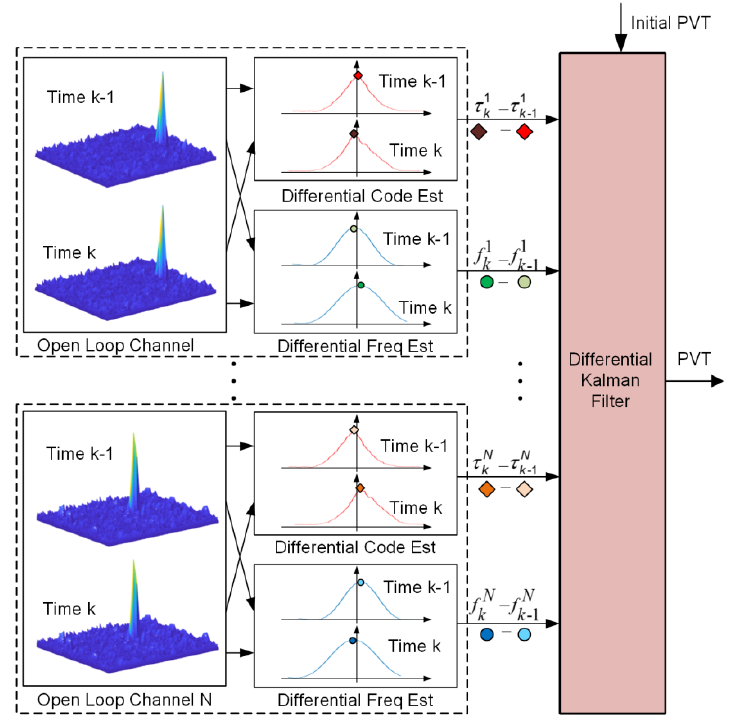
ff erential Kalman